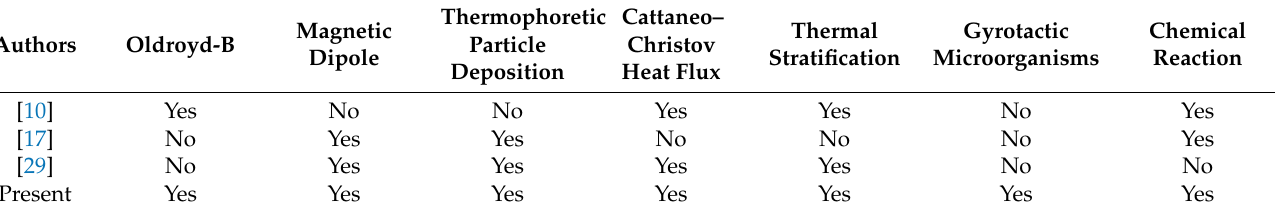
Table 1. A comparison of present work with closely comparable published research